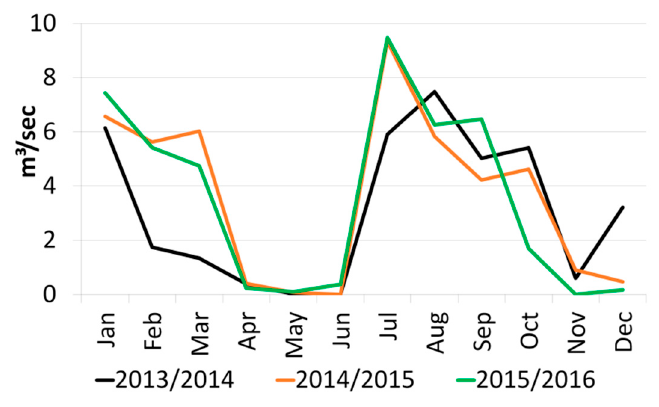
Figure 4. Irrigation water requirements for the 2013–2016 seasons.